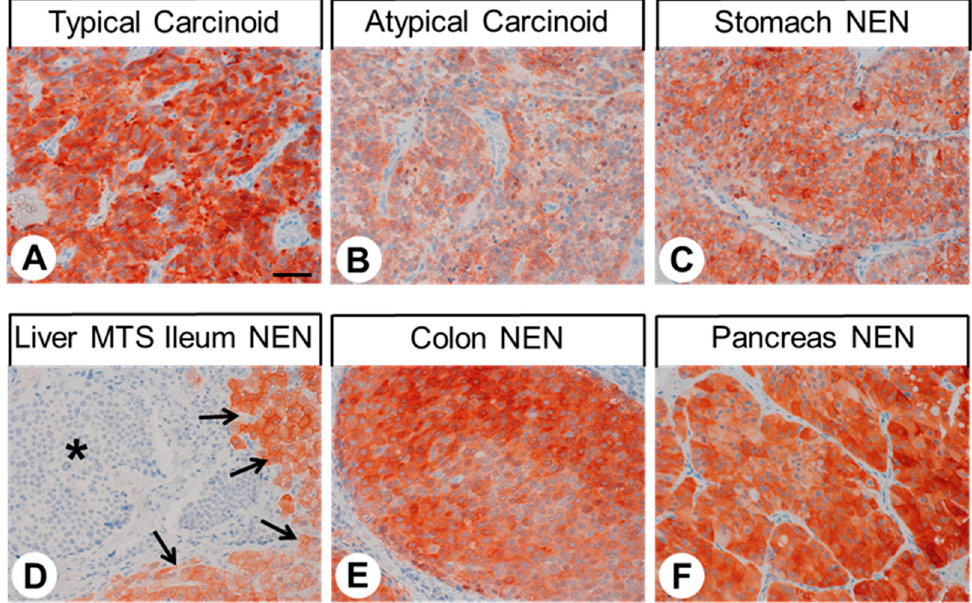
Figure 6. GPER expression pattern in different bronchopulmonary and gastroenteropancreatic neuroendocrine tumour entities. Immunohistochemical staining (red-brown colour) and counterstaining with haematoxylin. Scale bar: 100 µm ( A – F ). Asterisk in ( D ), liver metastasis (MTS) of an ileum neuroendocrine neoplasm (NEN); arrows in ( D ), surrounding GPER-positive non-neoplastic liver tissue.